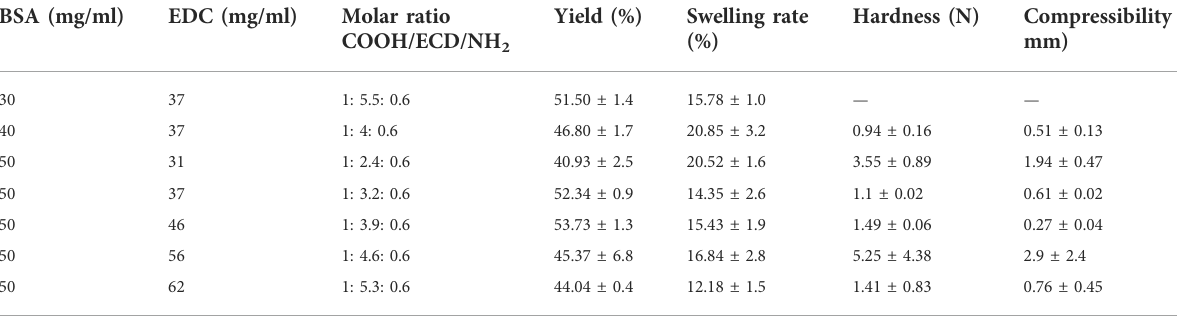
TABLE 1 Formation conditions, polymerisation yield, swelling rate and mechanical properties of the BSA